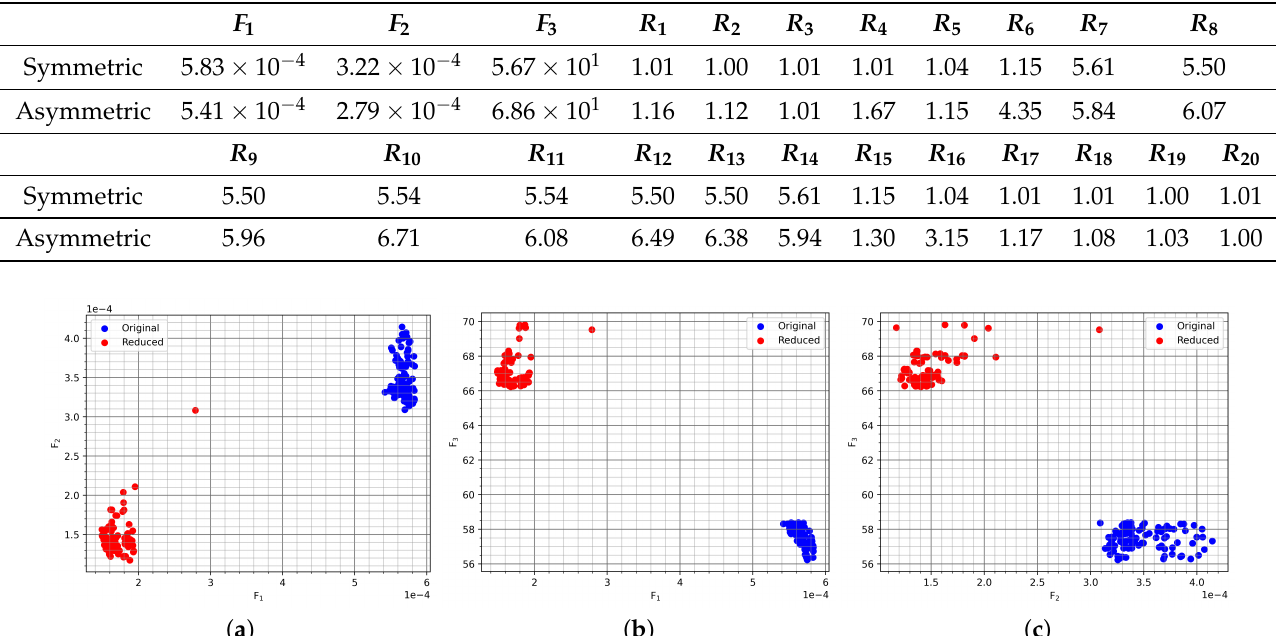
Figure 12. The comparison of the 100 cheapest symmetric solutions. With the blue color, all 20 coils are free to move, and with the red, only 12 coils are used, and they are constrained to move within the 5.5–20 mm